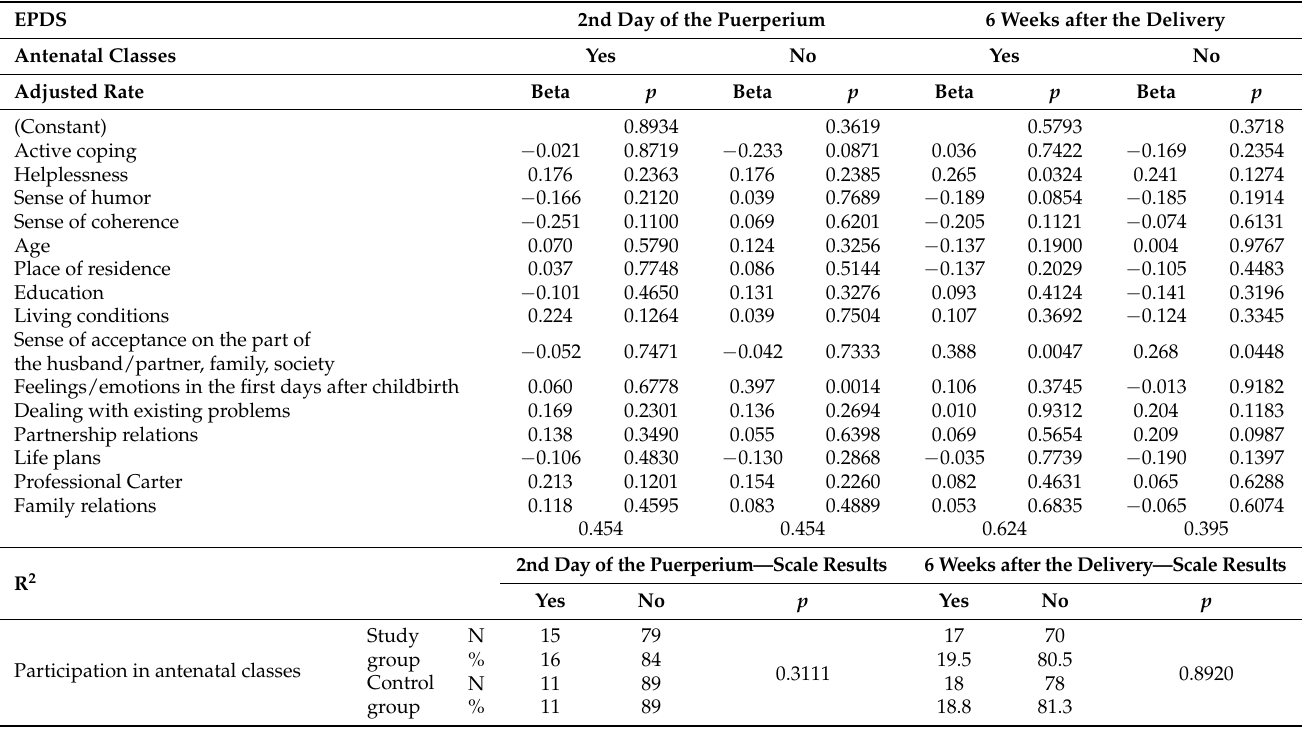
Table 2. The severity of depressive symptoms (EPDS) among women participating and not partici- pating in antenatal classes (linear regression using the introduction).